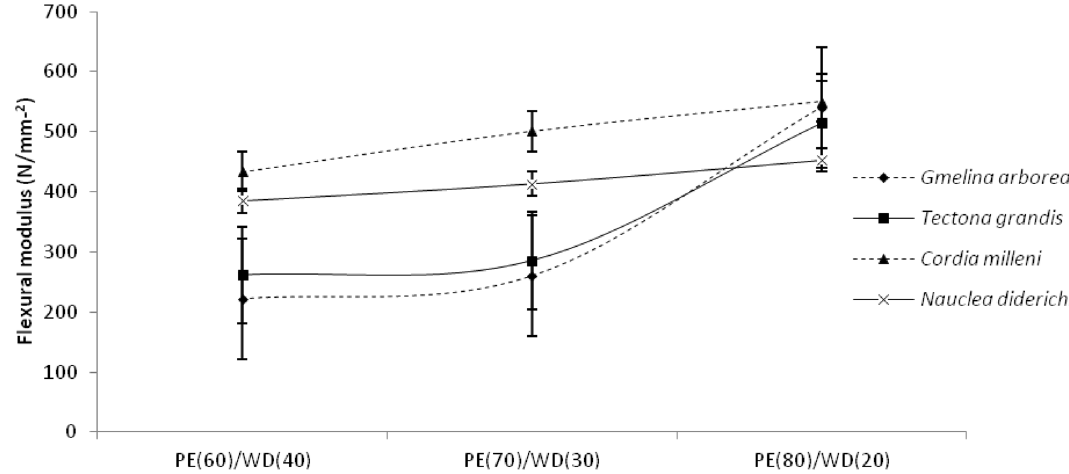
Figure 5. Flexural modulus of extruded-compressed biopolymer composites.